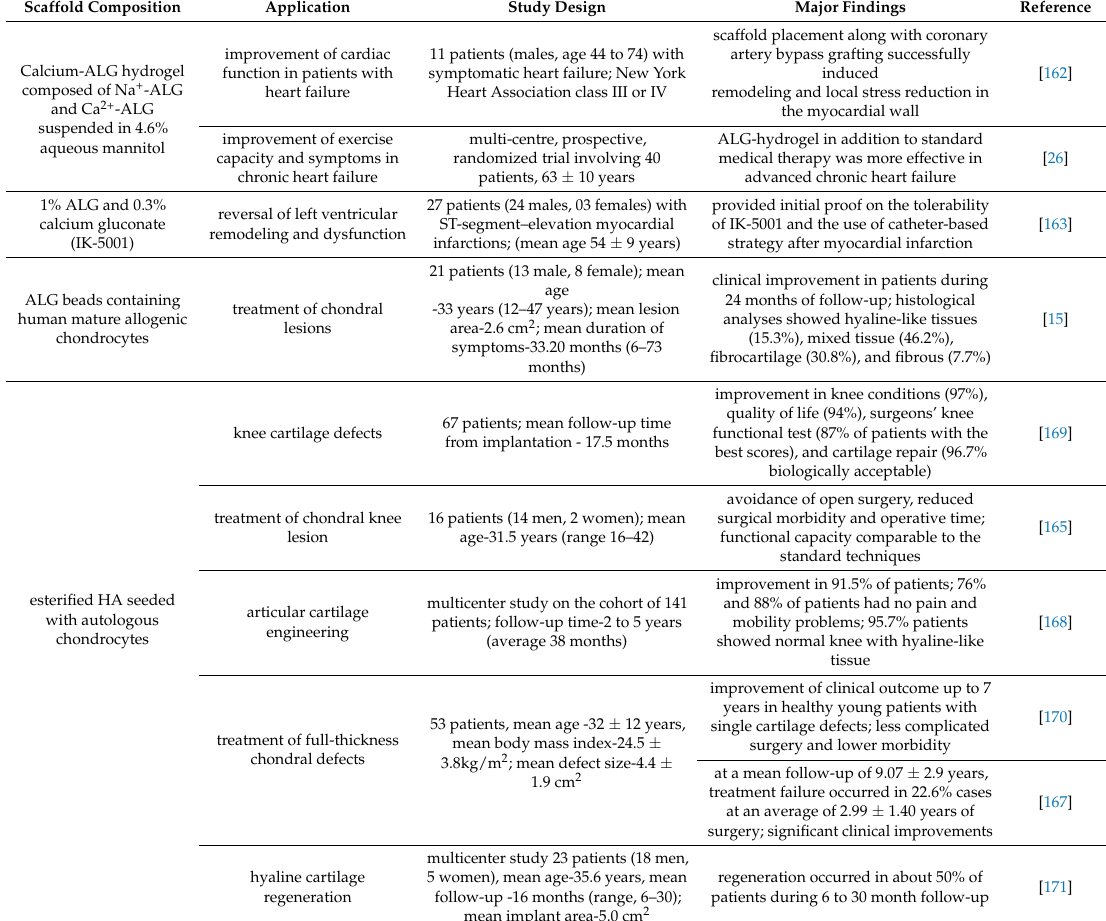
Table 3. Summary of human clinical studies exploring the efficacy of polysaccharide scaffolds. Scaffold